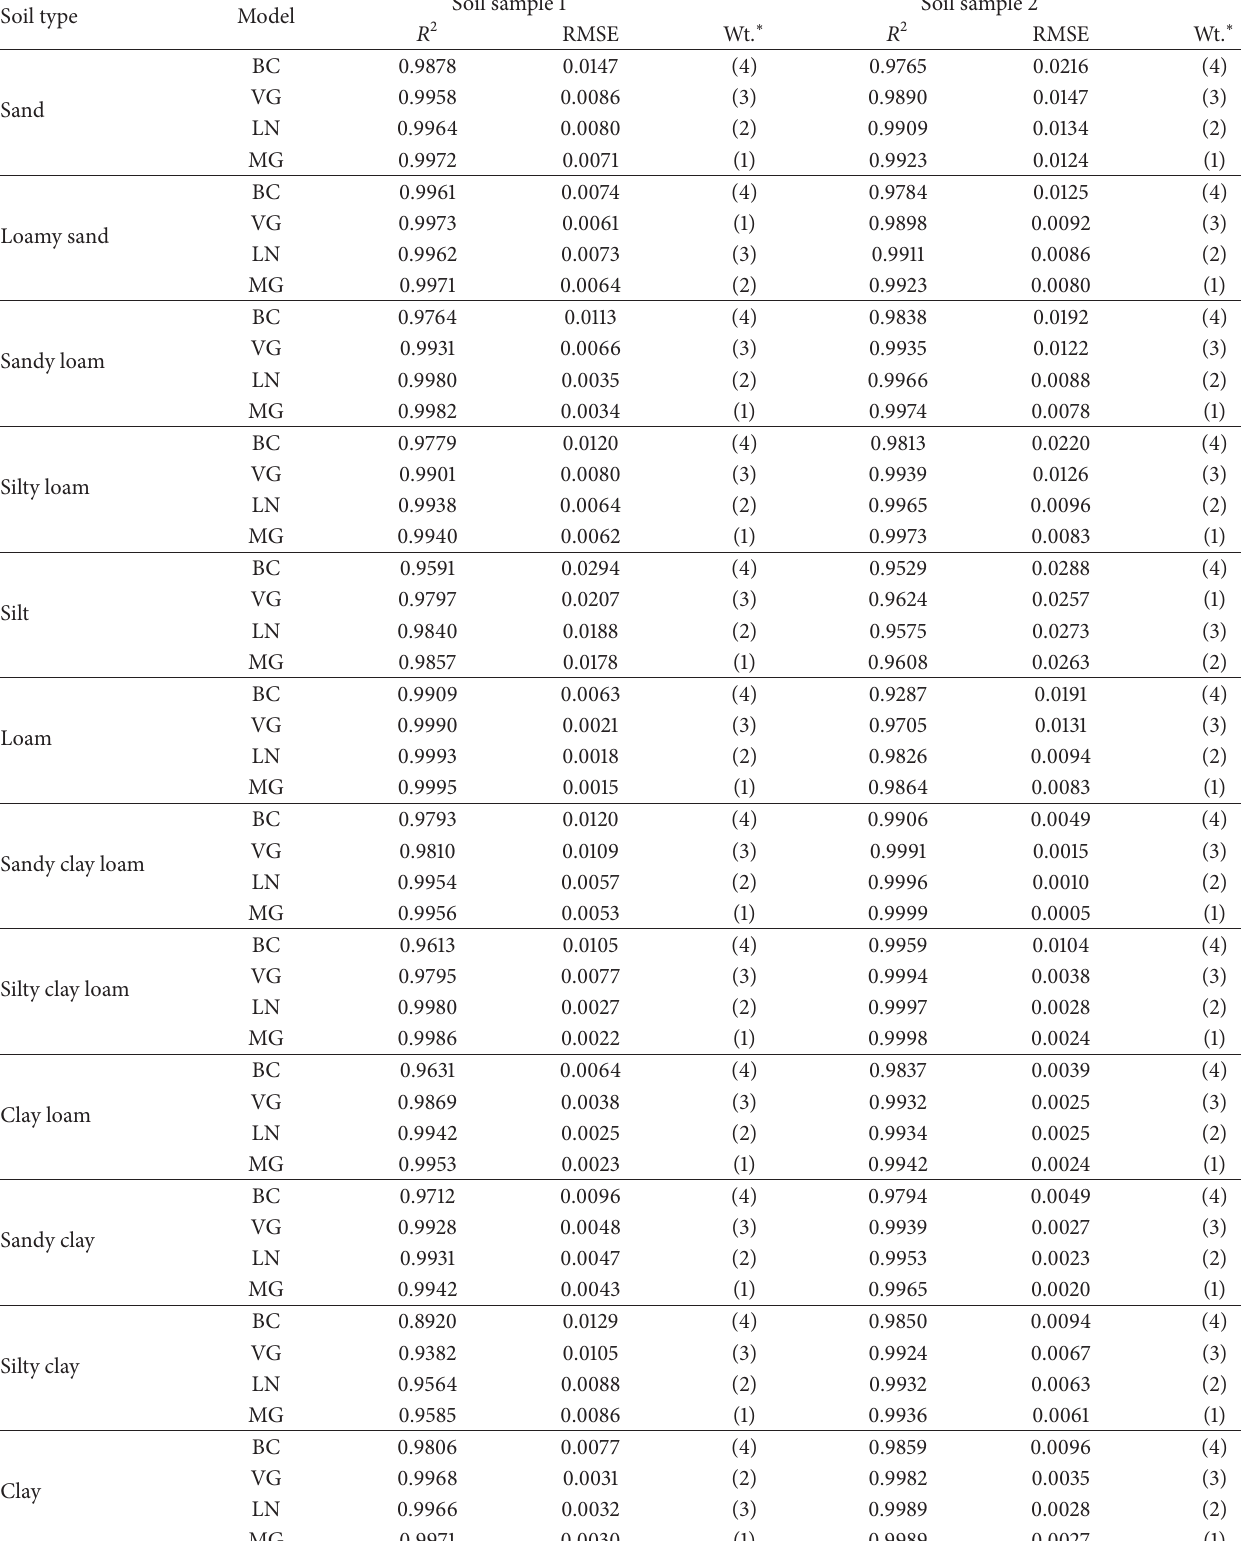
Table 4: Statistical measures of the models for various soil textural